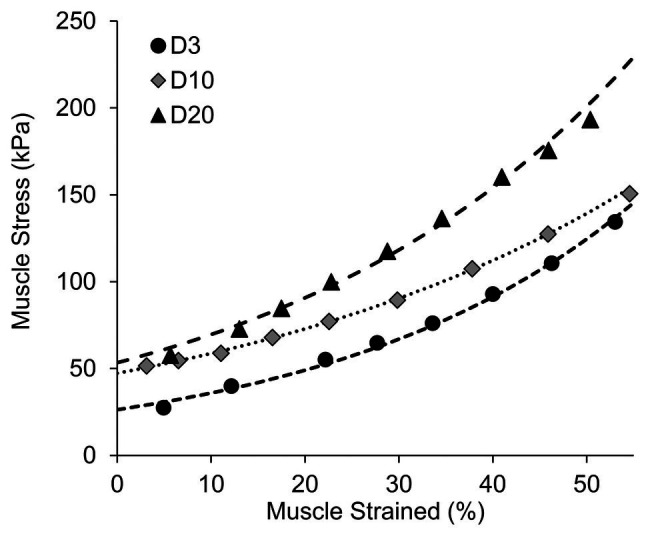
Representative samples showing the curve fitting procedures used to estimate the initial muscle stress.